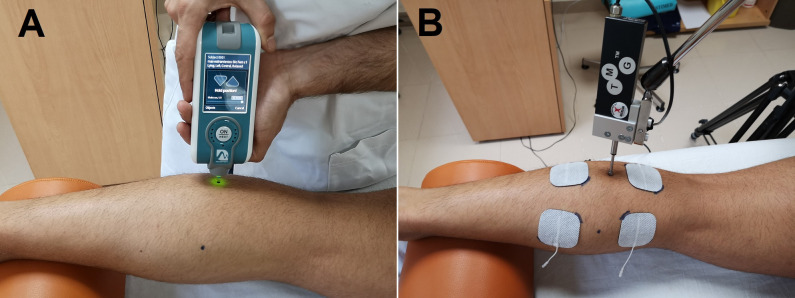
Measurement procedures.A: Myotonometry; B: Tensiomyography.